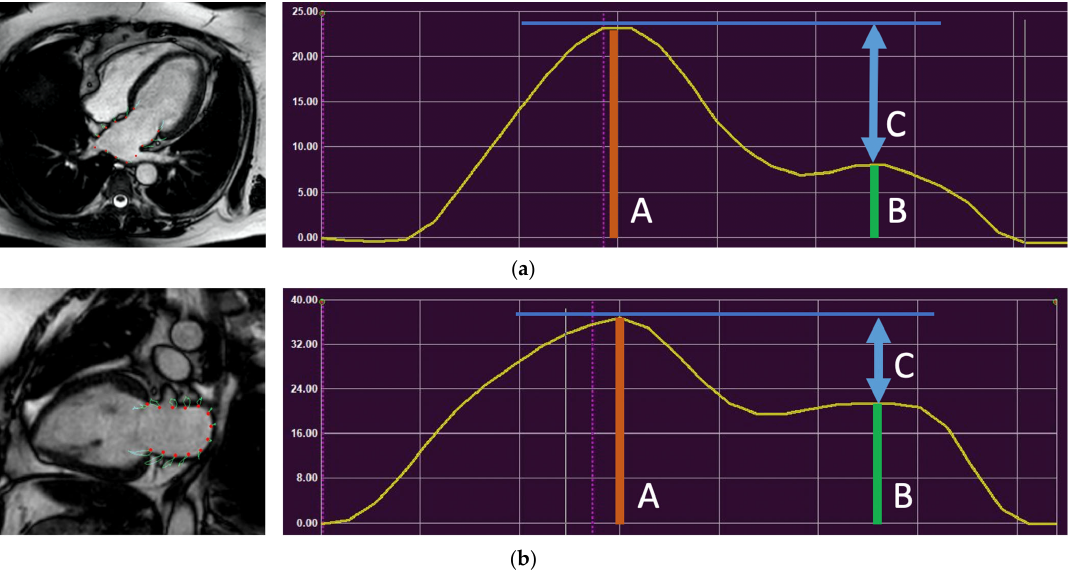
Figure 2. A 63 ‐ year ‐ old man with RCM. ( a ) LA endocardial contour was traced at end ‐ systole (i.e., LA end ‐ diastole). The LA function was evaluated using feature ‐ tracking analysis on four ‐ chamber ( a ) and two ‐ chamber ( b ) views. The zero reference was set at end ‐ diastole. LA strain was measured at end ‐ systole; the first peak (A ‐ orange line) corresponds with LA reservoir strain; the second peak (B ‐ green line) corresponds to contractile strain; and the difference between the reservoir and contractile strain (blue arrow line C) corresponds to conduit. Average LA strain was calculated as the mean value of the two ‐ chamber and four ‐ chamber views.